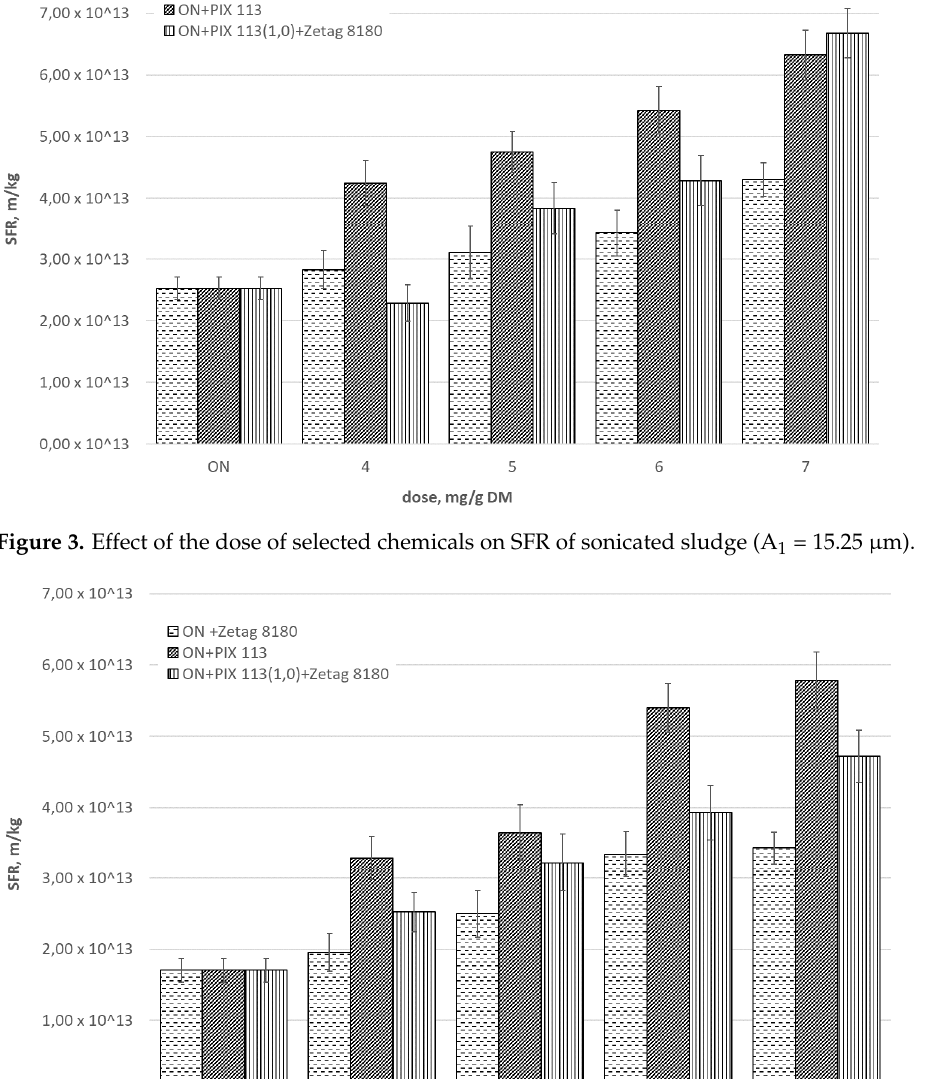
Figure 4. Effect of the dose of selected chemicals on SFR of sonicated sludge (A 2 = 45.75 µm). The effects of dewatering of the sonicated sludge prepared with chemical reagents: Zetag 8180, PIX 113 and combined ones are shown in Figures 5 and 6.